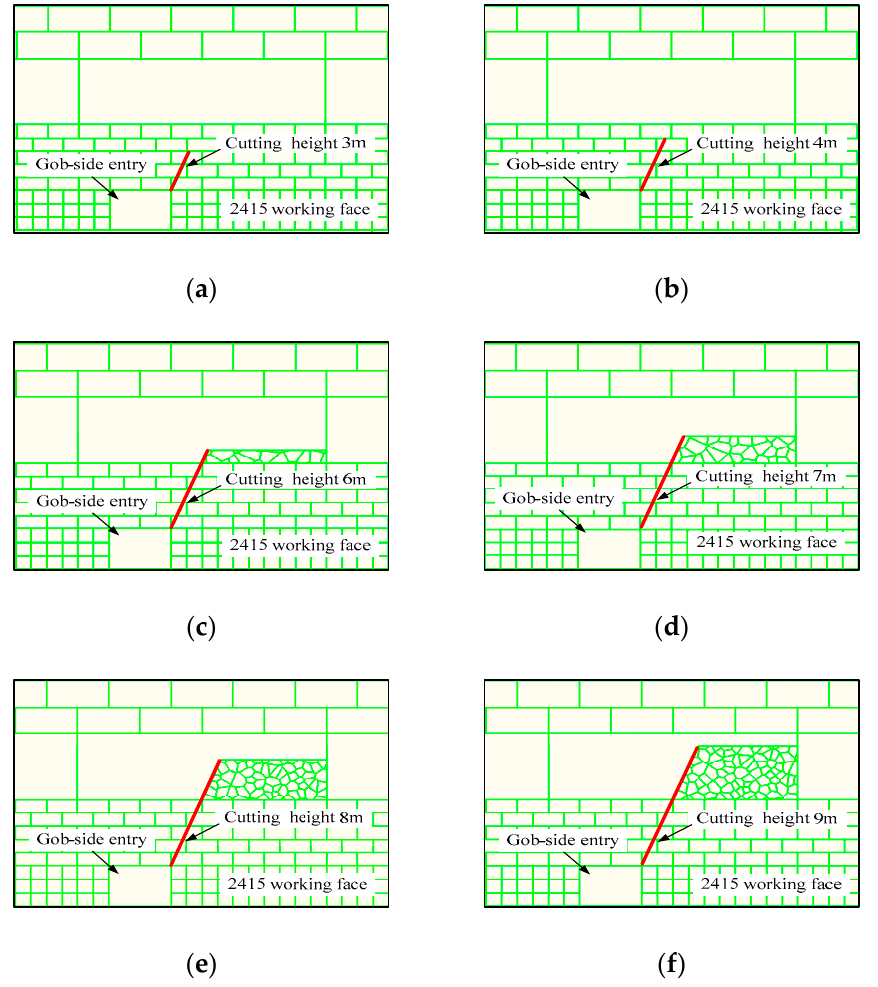
Figure 14. Numerical simulation schemes for different cutting heights. ( a ) Cutting height 3 m; ( b ) Cutting height 4 m; ( c ) Cutting height 6 m; ( d ) Cutting height 7 m; ( e ) Cutting height 8 m; ( f ) Cutting height 9 m.